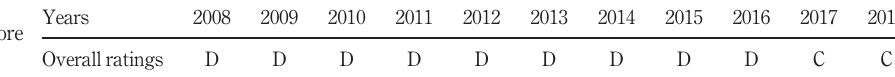
Figure 6. Comprehensive LCCE development